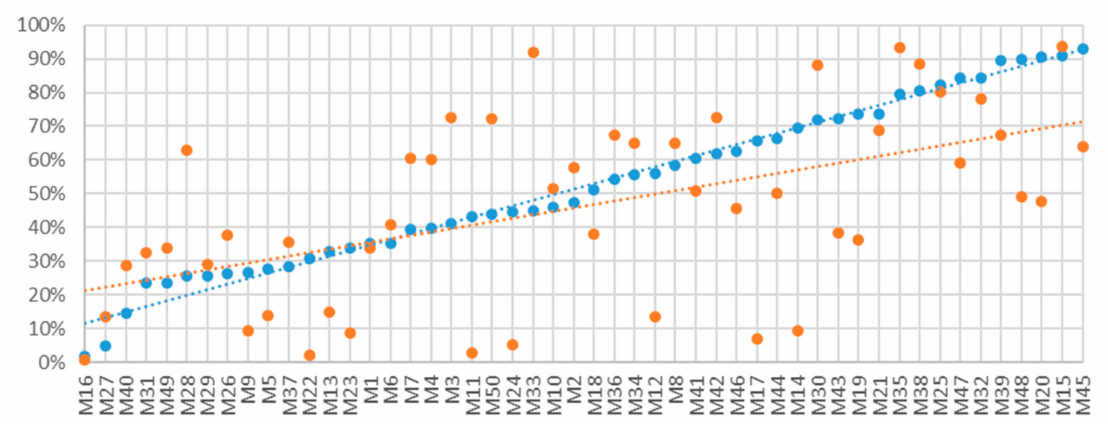
Figure 12. Graphic map load of maps from the Ref-Set obtained during user testing (L UP , marked blue) and measured by IC3 metric (L IC3 , marked orange) sorted in ascending order by L UP , dotted lines indicate